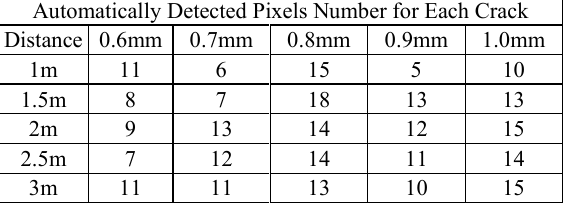
Table 9. The number of automatically detected pixels.